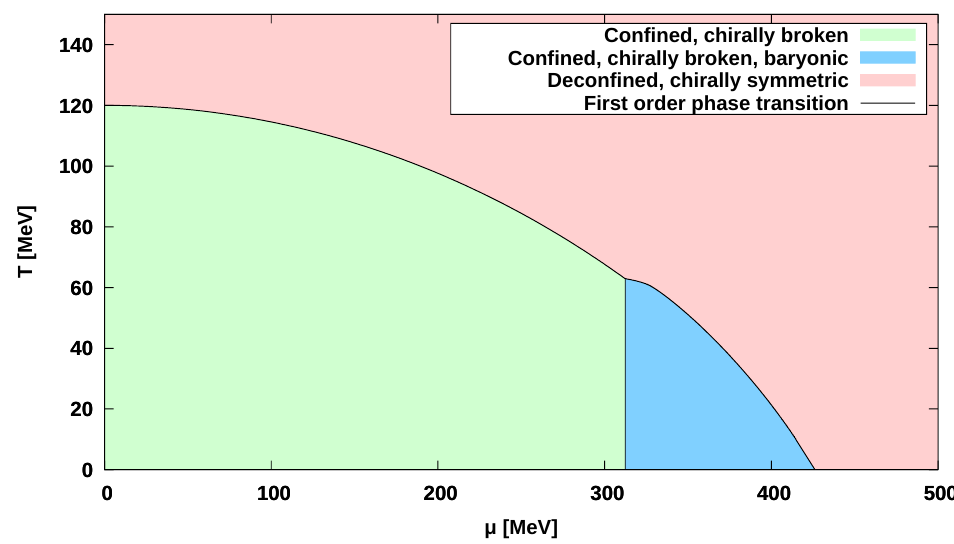
Figure 2 . Phase diagram on the ( (cid:22); T )-plane for the homogeneous